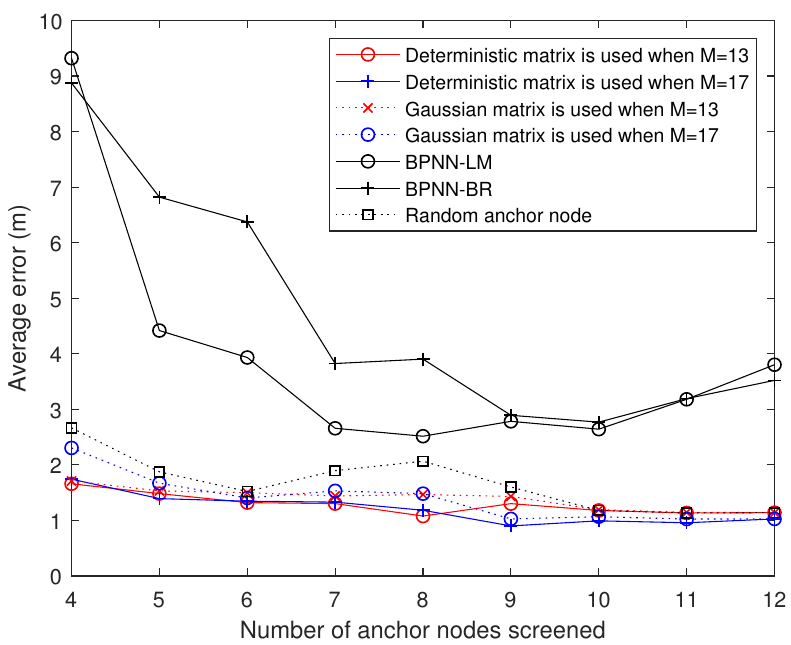
Figure 6. Performance comparison in different number of classification and different number of screening anchor